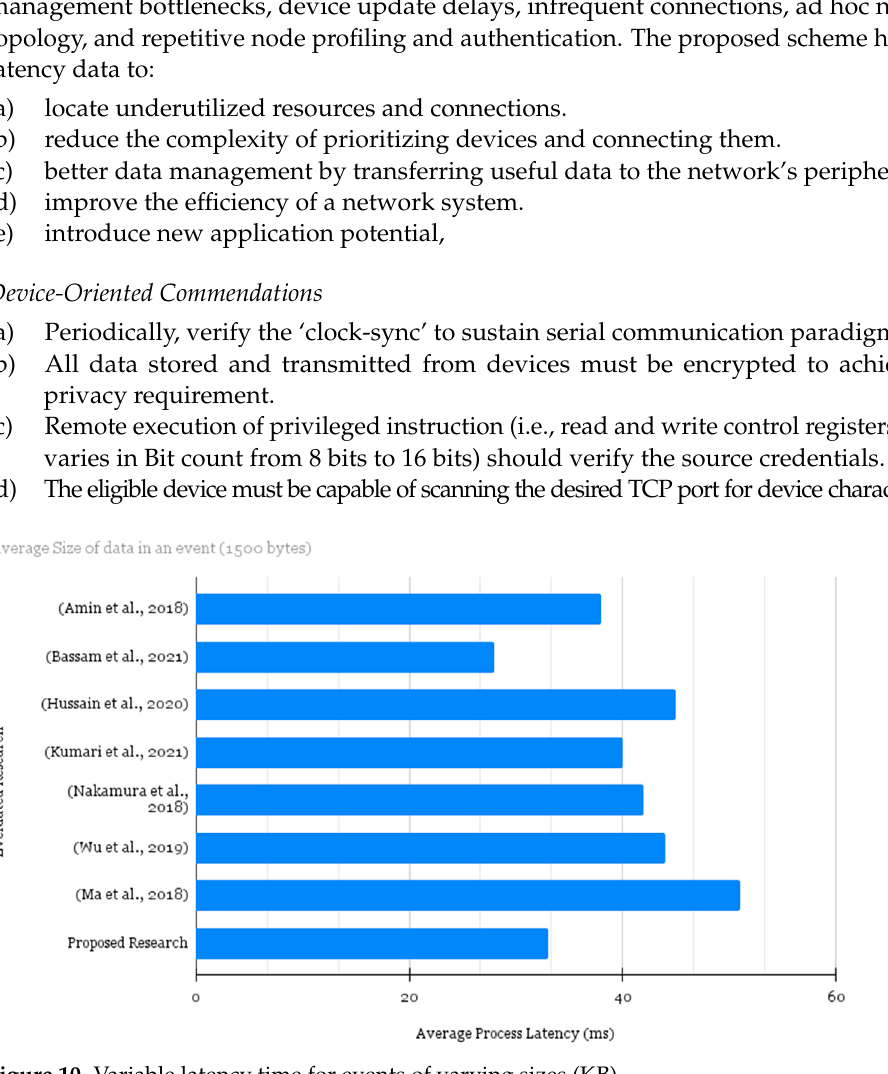
Figure 9. Energy analysis.